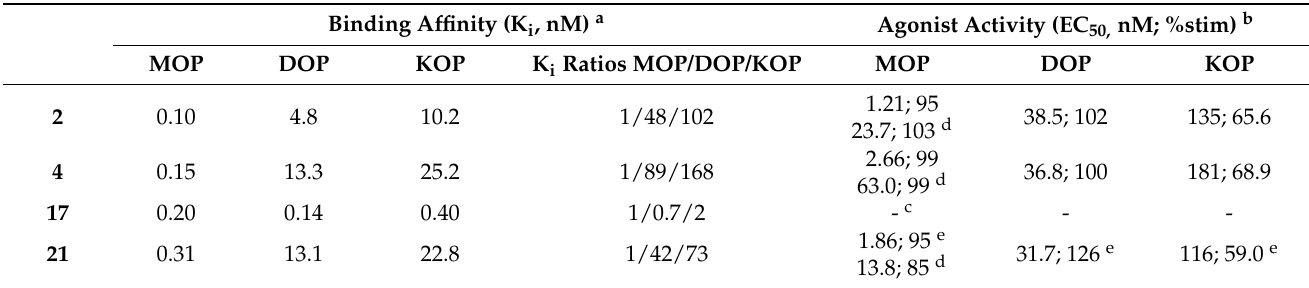
Table 6. Binding affinities and agonist potencies of differently 5-substituted N -methylmorphinan-6-ones 2 , 4 , 17 and 21 . Binding Affinity (K i , nM) a Agonist Activity (EC 50, nM; %stim) b